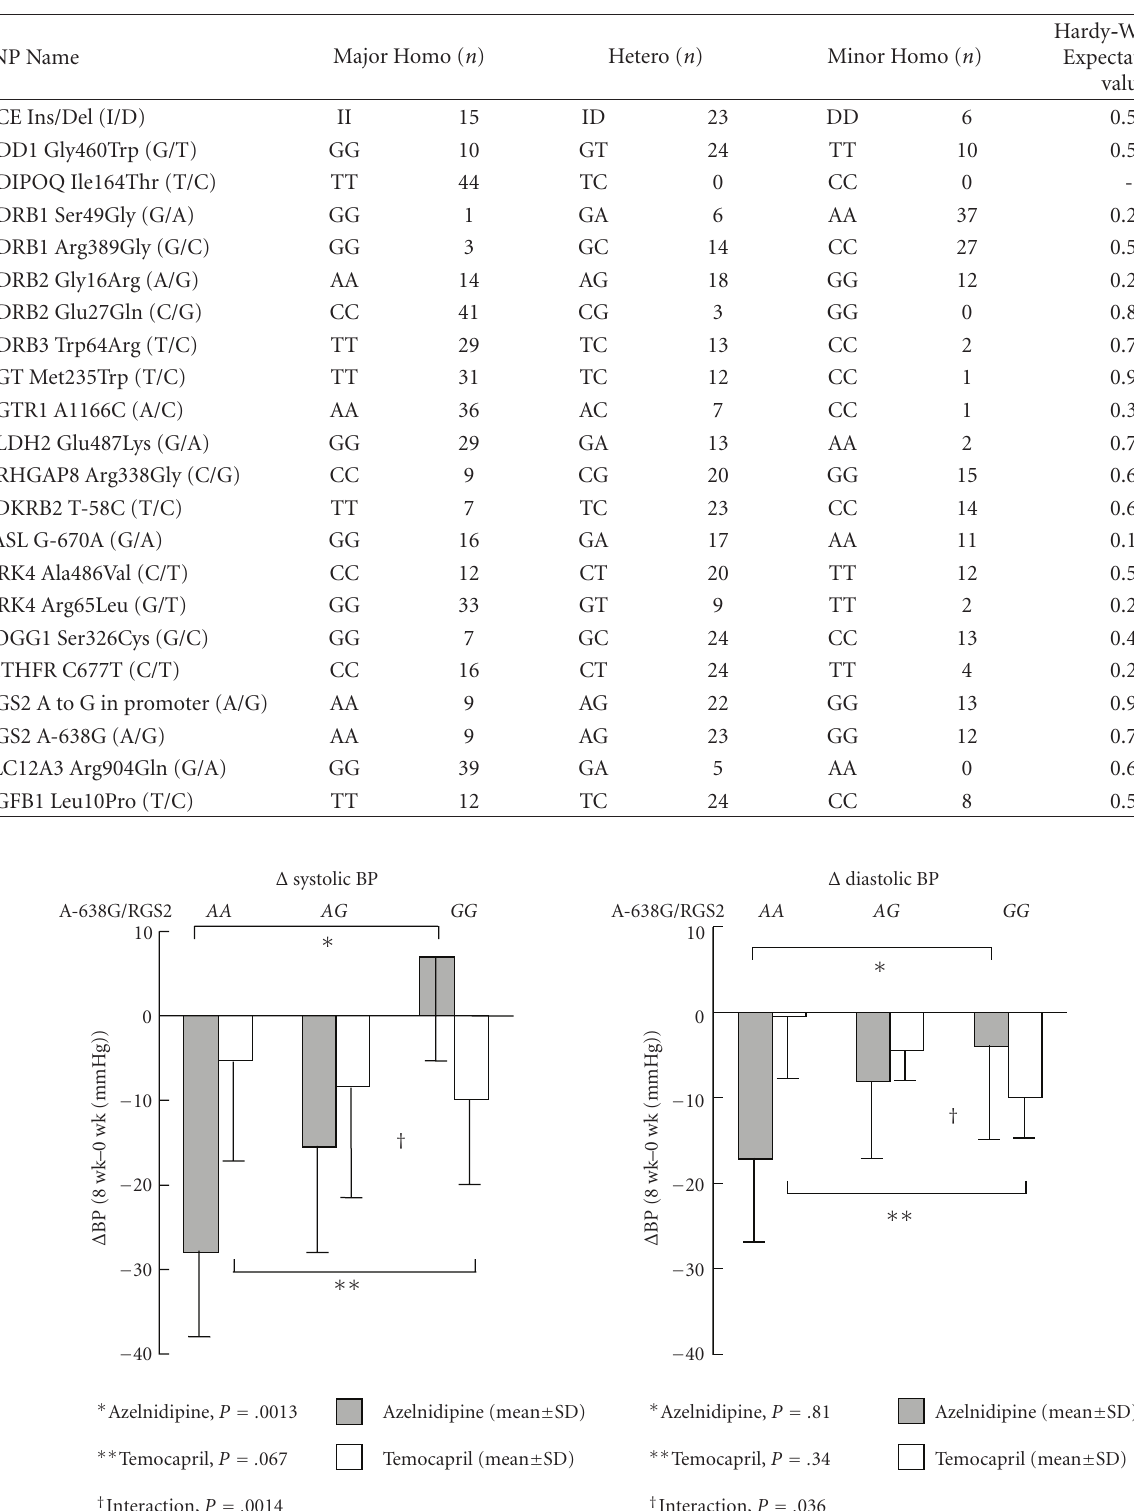
Table 3: Genotype frequencies of 22 SNPs.